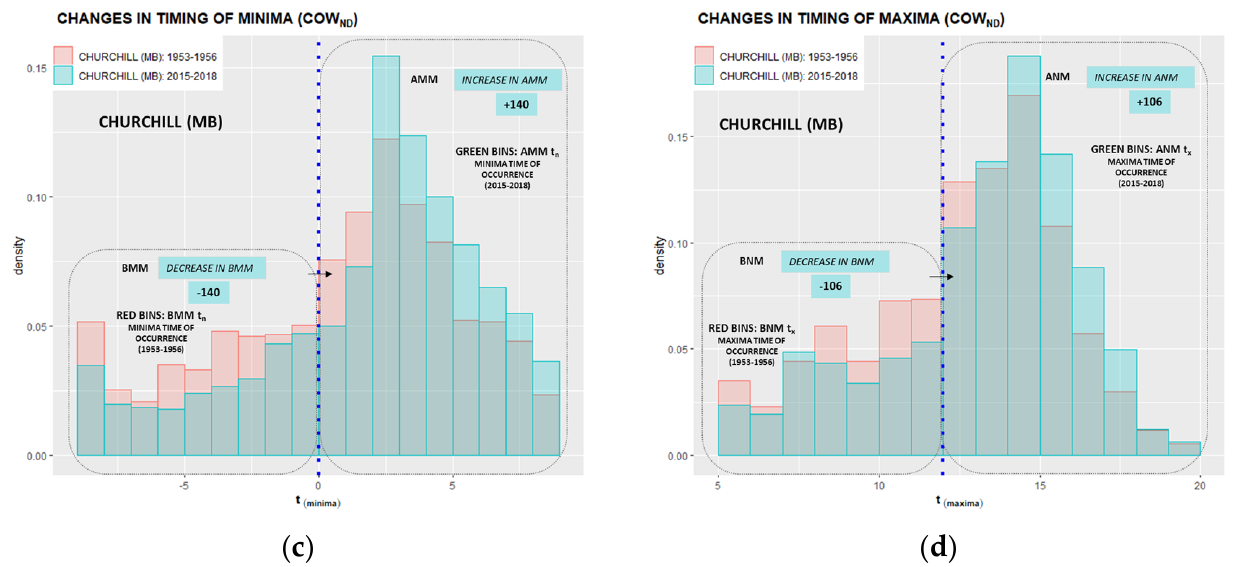
Figure A22. Northern Canada climate region: Baker Lake (NU) and Churchill (MB). Time evolution of the Diurnal Extrema Timing (DET) histograms at Baker Lake ( a , b ), and Churchill ( c , d ) stations. Migration of the Before Midnight Minima (BMM) to After Midnight Minima (AMM) and migration of the Before Noon Maxima (BNM) to After Noon Maxima (ANM) between four-year averages at the beginning (1953–1956) and ending (2015–2018) of data ranges. The blue dotted line represents midnight delineation ( left ) and noon delineation ( right ).